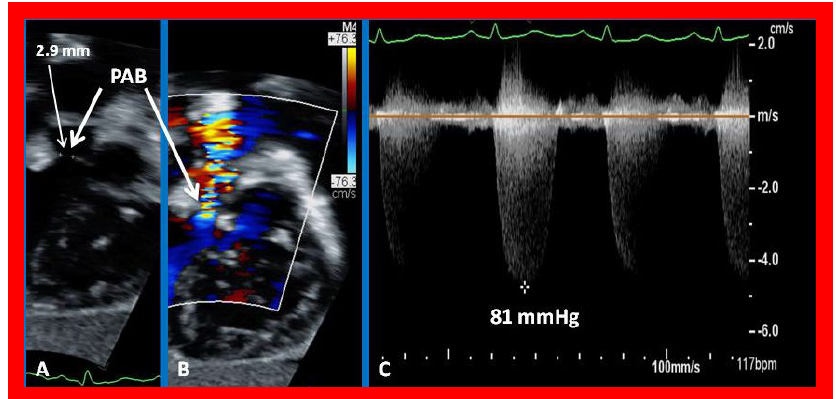
Figure 22. Selected echocardiographic video frames demonstrating pulmonary artery band (PAB) with narrow diameter of 2.9 mm by 2D ( A ) and by color flow ( B ) and a high gradient (81 mmHg) by continuous wave Doppler ( C ) are shown.